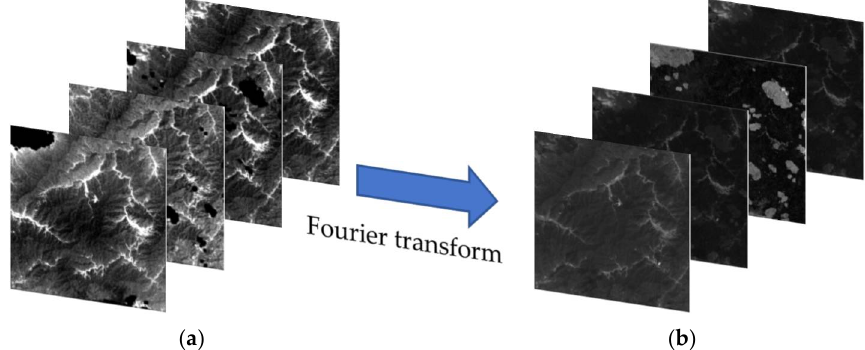
Figure 2. ( a ) The rearranged spatial–temporal tensor; ( b ) the spatial–frequential tensor.